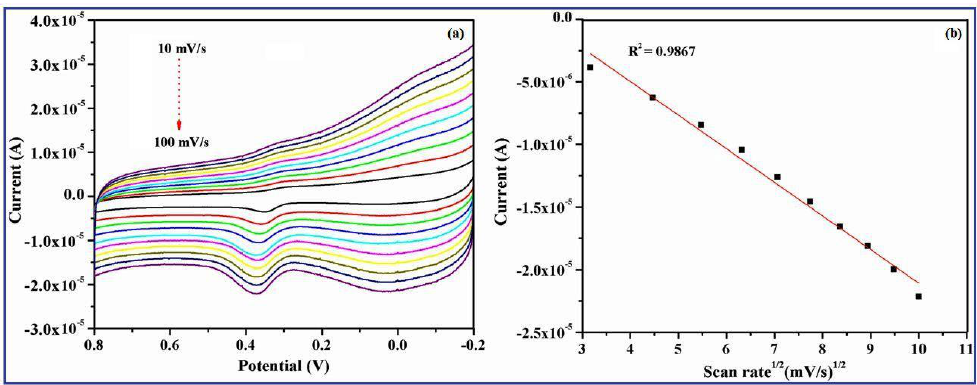
Figure 8. Cyclic voltammetric responses of γ-Fe 2 O 3 nanobelts/GCE obtained at 0.3 mM UA in 0.1 M PBS (pH 7.4) ( a ) at different scan rates (10–100 mV/s) and ( b ) calibration curve plotted against square root of the scan rate and oxidation current.